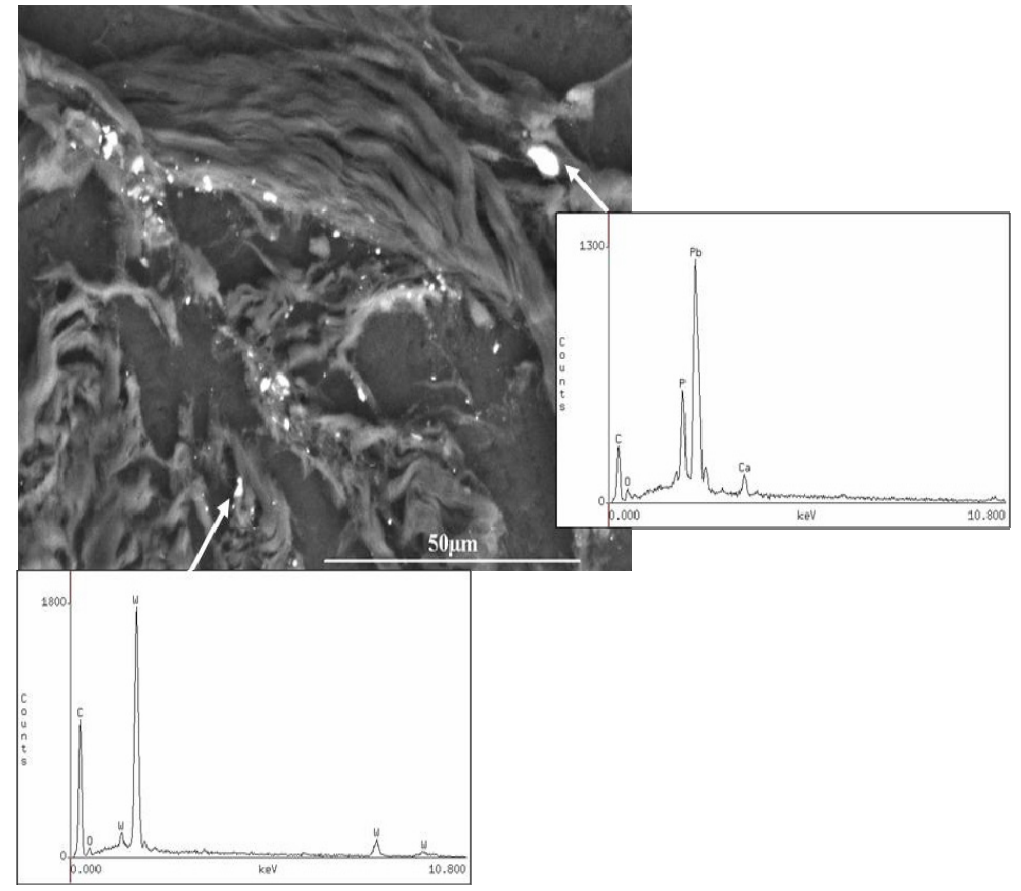
Figure 3. Case 1: Scanning electron microscopy (SEM) image and energy-dispersive X-ray analysis (EDXA) of the granular material embedded in the fibroadipose tissue demonstrating the presence of tungsten and lead. SEM original magnification